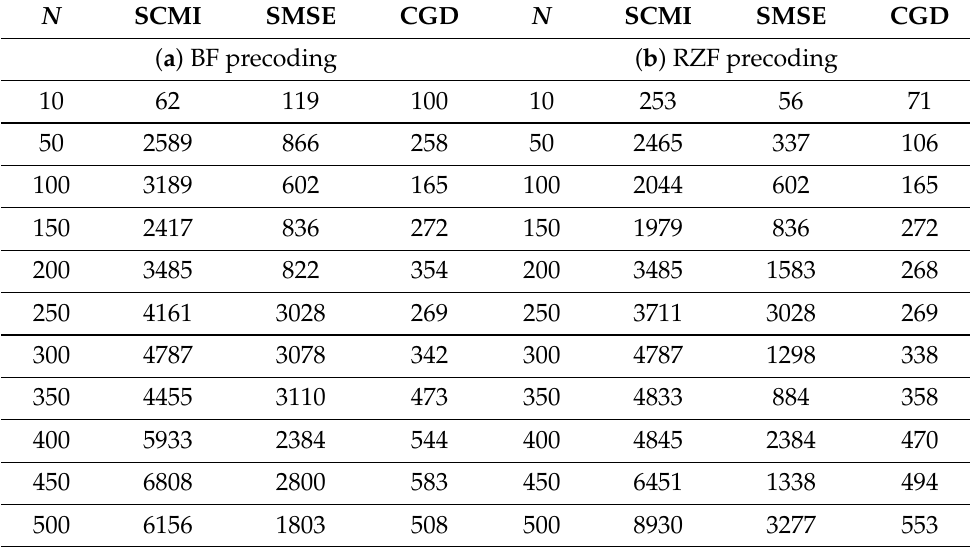
Table 5. The number of iterations per each training sequence algorithm required to converge with respect to the number of BS antennas N for the pilot length in BF and RZF precoding in the OR model with ω = 5 ◦ , D = 1/2, T = 100 symbols, ρ d = 5 dB and K = 10